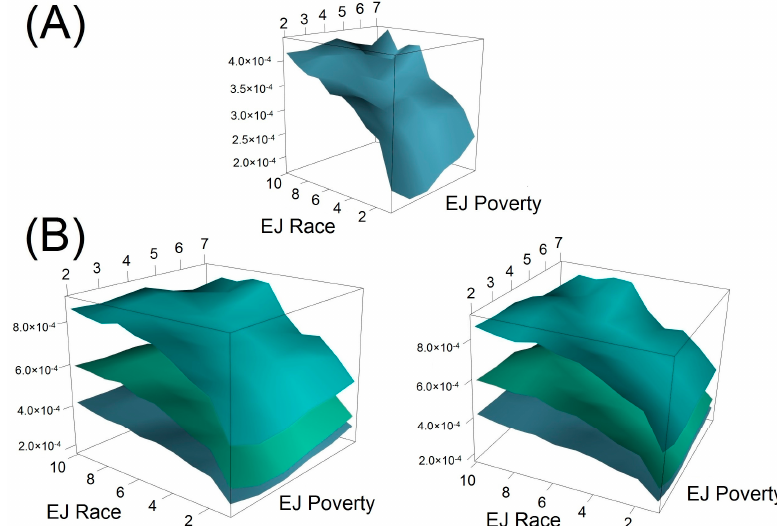
Figure 2. Two Environmental Justice (EJ) Indicators 3D Plot. ( A ) Single-chemical (benzene) ADD levels (mg-day/kg) associated with both poverty and race scores (color in sky blue); ( B ) Multiple-chemical ADD levels (mg-day/kg) associated with both poverty and race scores. These two graphs are snapshots of different perspectives of the same 3-D plot. The bottom layer (color in sky blue) represents the ADD level of benzene; the middle layer (color in aquamarine) represents the ADD level of benzene plus that of adjusted 1,3-butadiene; the first layer (color in cyan) represents the ADD level of benzene plus that of both adjusted 1,3-butadiene and acetaldehyde.